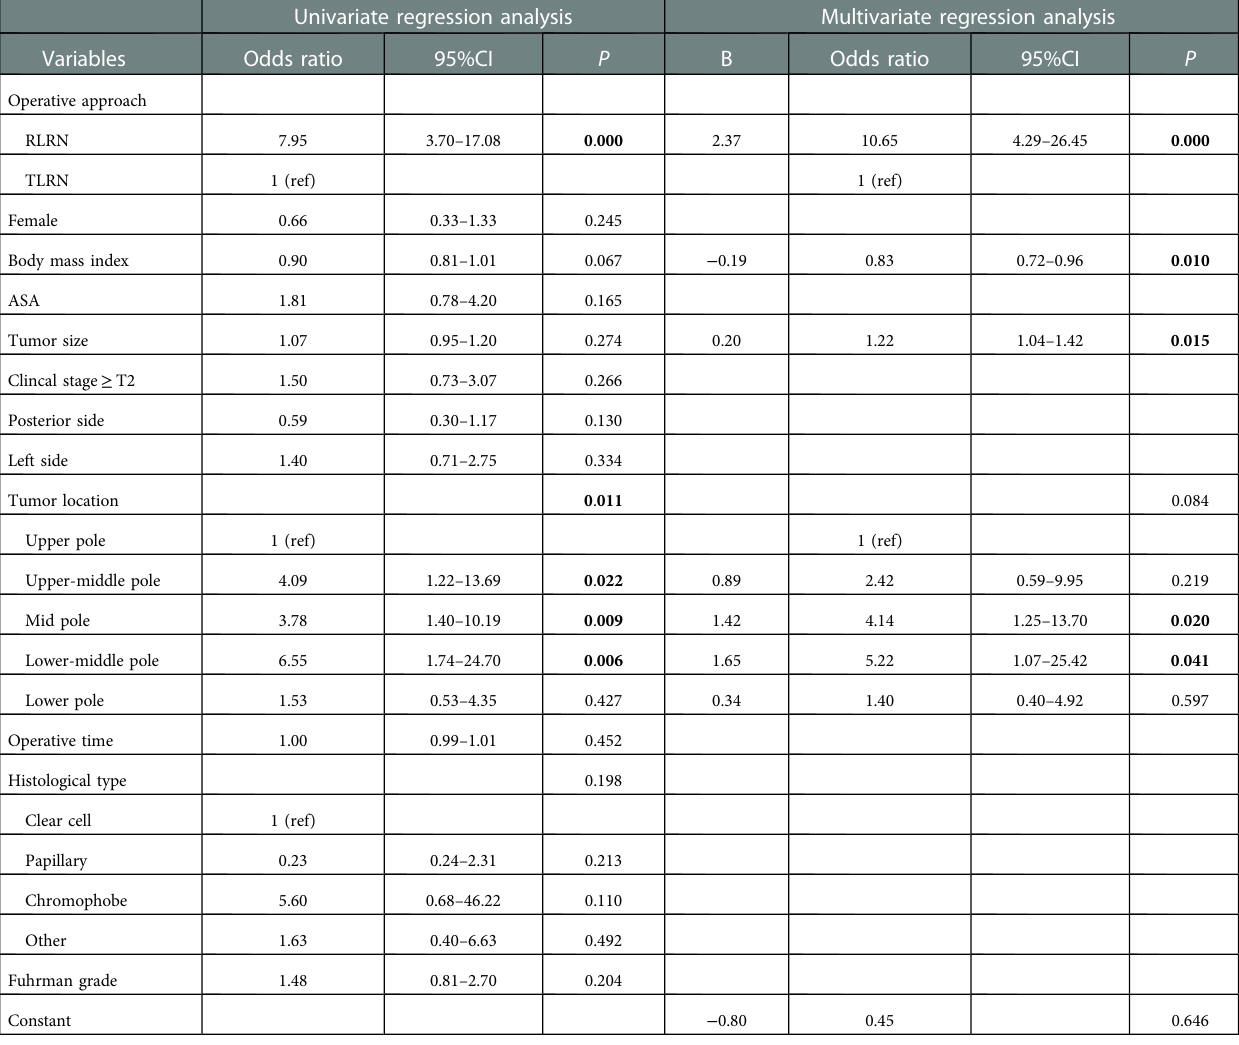
TABLE 3 Variables associated with poor integrity score (integrity score ≤ 3) in univariate and multivariate analysis.